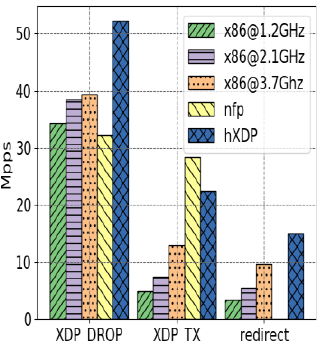
Figure 12. Baseline output when calling a helper function.